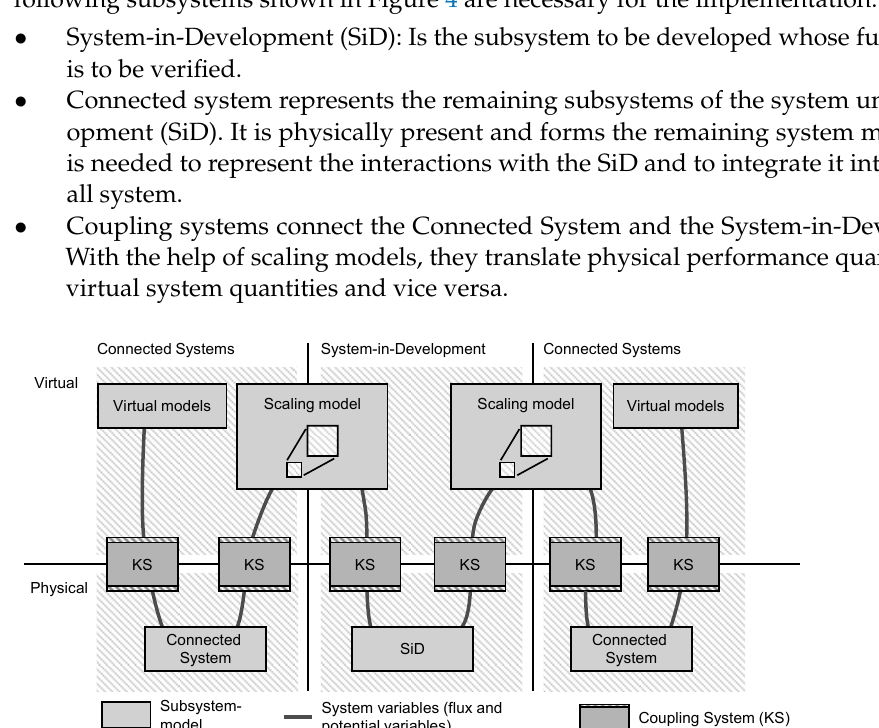
Figure 4. Example XiL architecture for scaled validation.